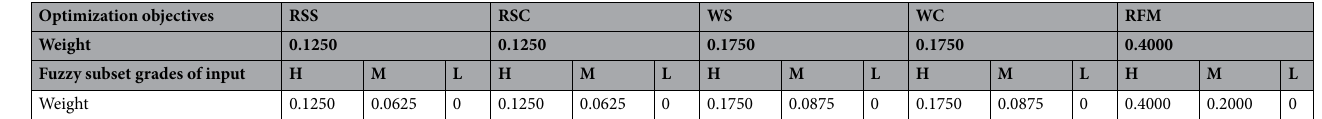
Table 13. The weight values of the fuzzy subset grades on the input for each optimization objective.